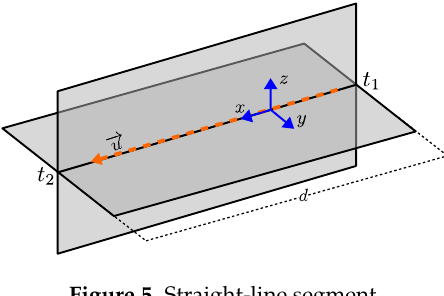
Figure 5. Straight-line segment.